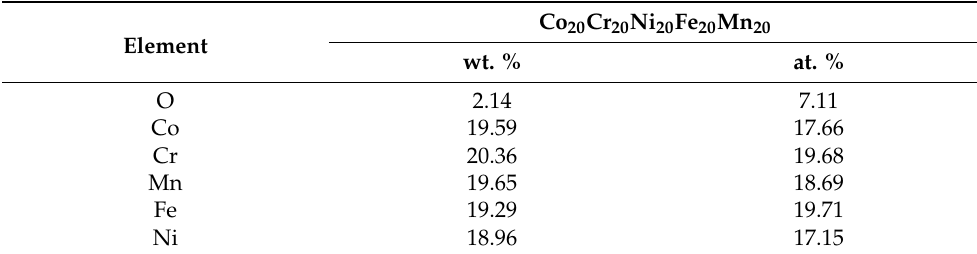
Table 3. Semi-quantitative analysis of Co 20 Cr 20 Ni 20 Fe 20 Mn 20 (at%) powder after ball milling, as obtained from EDS.